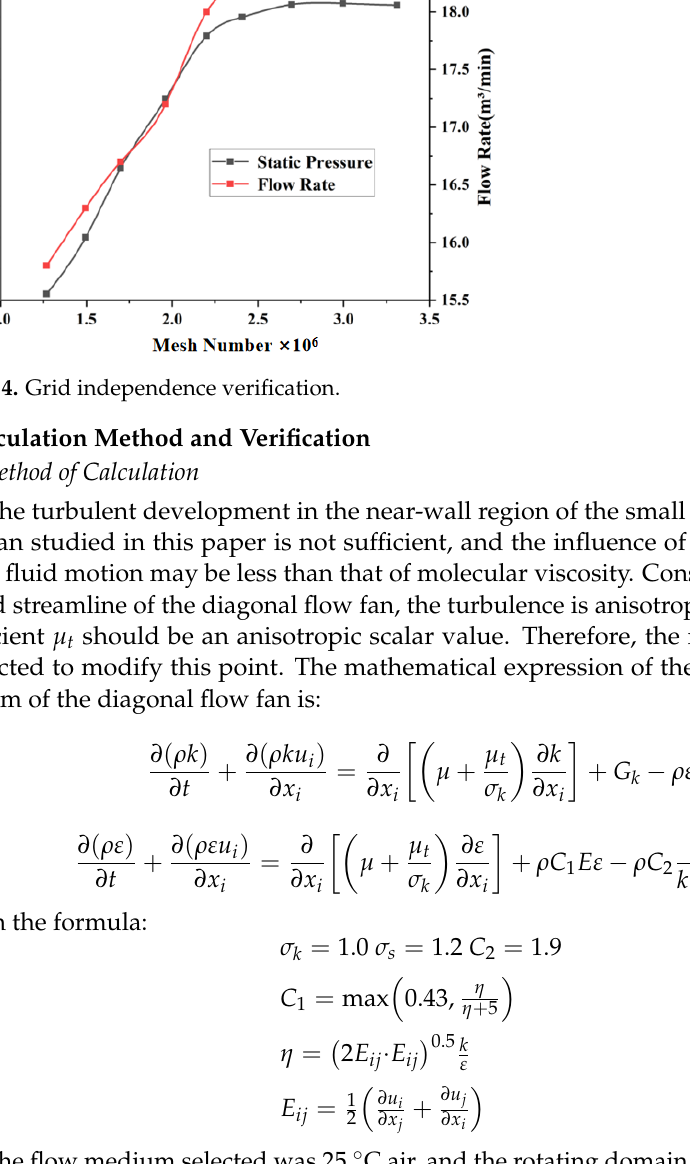
( b ) Figure 3. Grid model of diagonal flow fan. ( a ) Moving blade area grid. ( b ) Guide vane area grid. After the grid quality meets the requirements, it is also necessary to verify the inde- pendence of the number of computational grids. Too few grids can easily make the calcu-